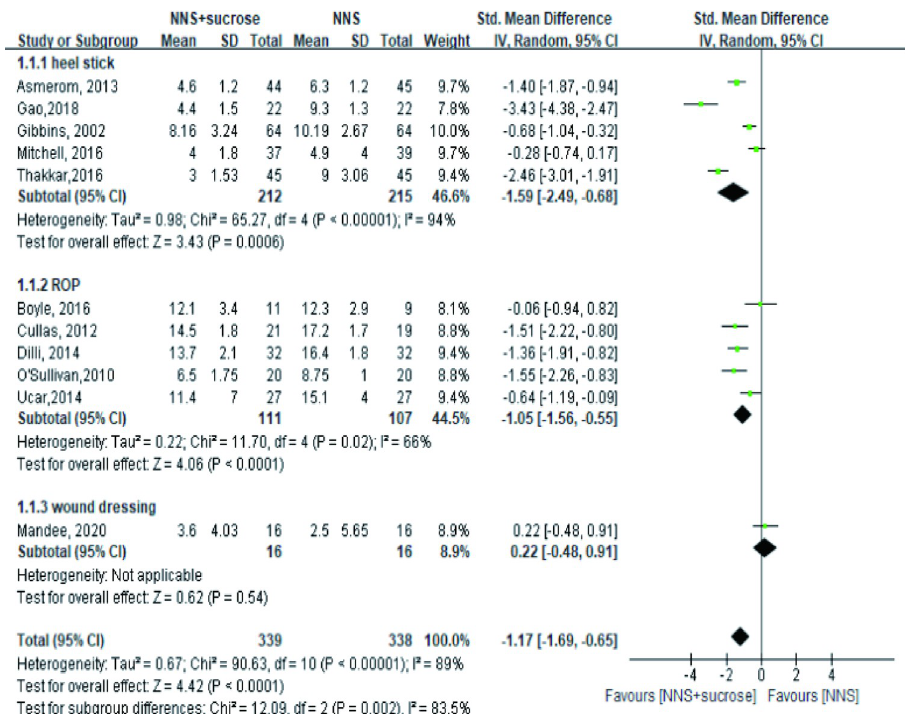
Fig 3. Forest plot of pain score comparing the combined intervention (NNS and sucrose) with applying NNS alone during different painful procedures. NNS: nonnutritive sucking. https://doi.org/10.1371/journal.pone.0268033.g003 3.2.4 NNS+OS versus breastfeeding or breast milk. The comparison between OS+NNS and breast milk showed no difference in effects for pain relief despite the heterogeneity in study design, intervention methods, pain procedures, outcome assessment and target